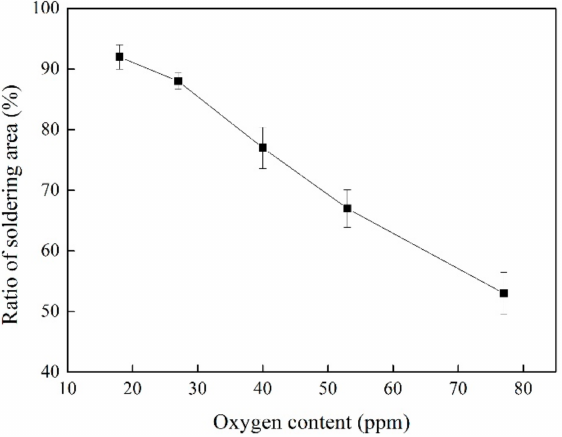
Figure 7. Relationship between oxygen content in the Au-20Sn solder and ratio of soldering area of in the chips packaged using these Au-Sn